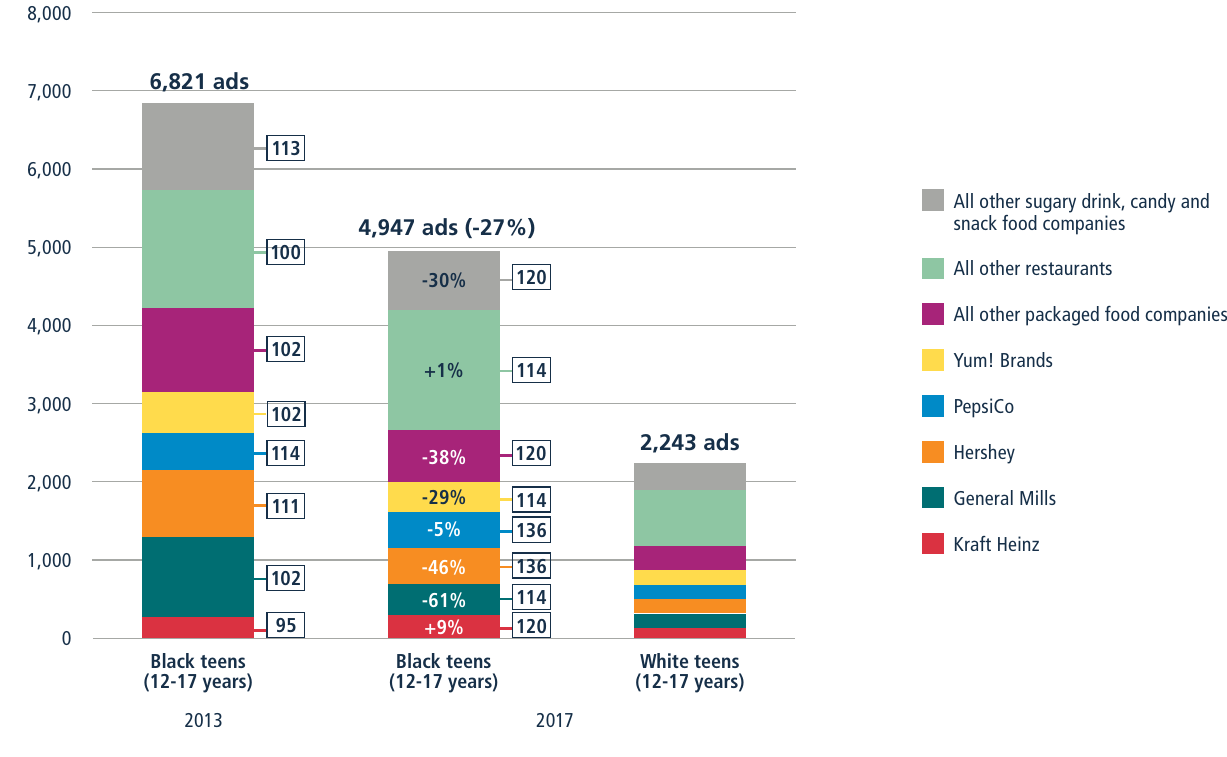
FIGURE 10. BLACK AND WHITE TEENS’ EXPOSURE TO ADVERTISING ON ALL TV PROGRAMMING BY